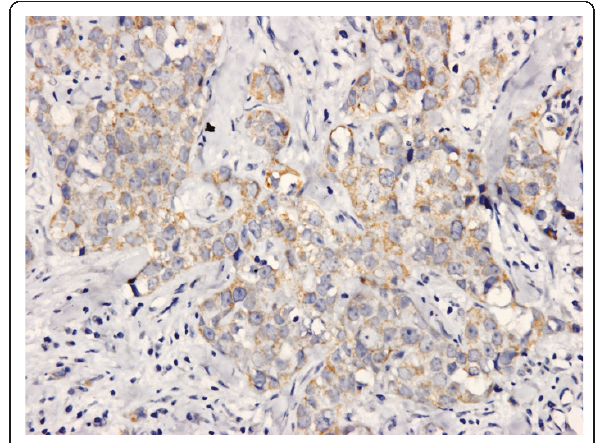
Figure 2 Higher power view of representative cytoplasmic immunostaining of Smac in IDC . Original magnification for this figure: ×400.